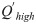
The effect of blood rheological model and flow rate on the average tissue drug concentration.Increases in bulk flow rate were found to correspond with reduced area-weighted average drug concentrations (AWAC) in the tissue. Rheological models which produced larger recirculation lengths were also found to produce lower AWAC values; however, the deviation from the AWAC obtained with the Newtonian model was observed to be less than 5% for each non-Newtonian case. It was only when modelling plasma instead of blood that any considerable deviations from the Newtonian model’s AWAC were observed and even these were only observed at Q′high.